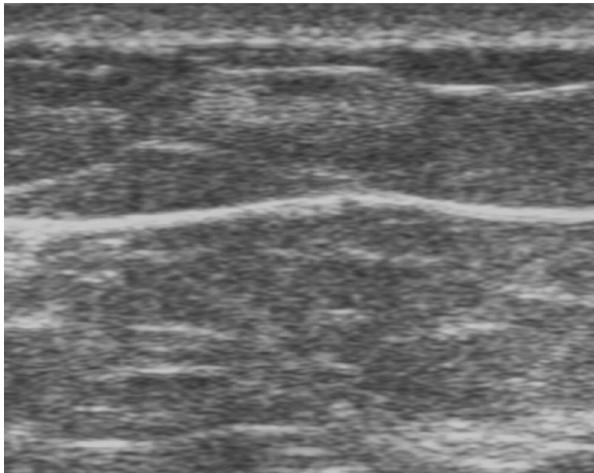
Fig. 5 Haemangioma in a 72-year-old woman, presenting with a slowly growing,superficial breast opacity. Ultrasound:oval-shaped,hyperechoic mass of the subcutaneous fat, parallel to the skin. Surgical resection in order to eliminate angiosarcoma: confirmation of the benign nature of the